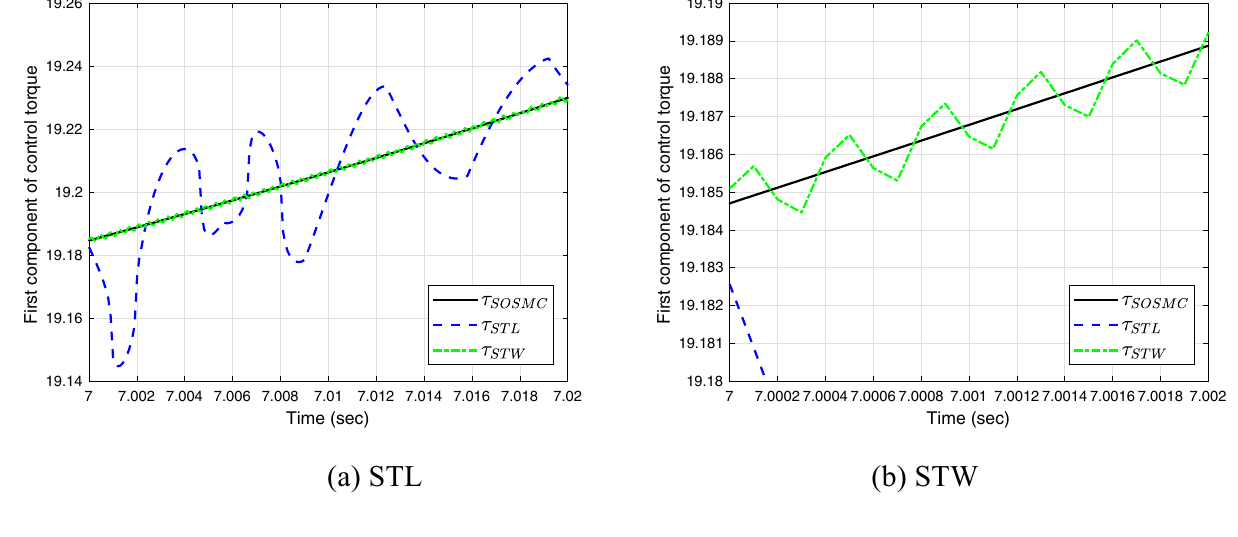
Fig. 12 Comparison of zoomed torques 𝜏 1 to show STL and STW